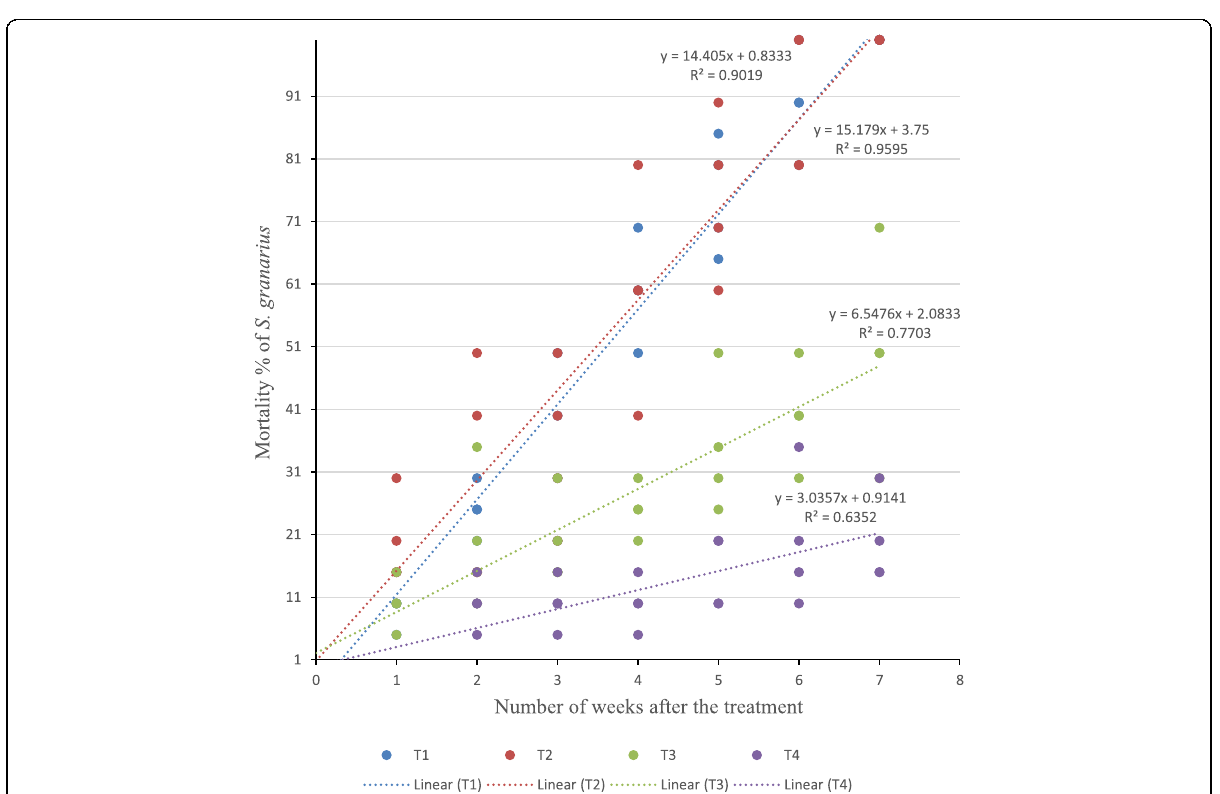
Fig. 3 Mortality of adults of granary weevils ( Sitophilus granarius ; strain SG5) as a result feeding on mixtures of Metarhizium anisopliae (strain MA1) conidia + wheat flour for 24 h. Ratios of mixtures (g/g) are T1 = 0.2:2.0; T2 = 0.1:2.0; T3 = 0.05:2.0; T4 =